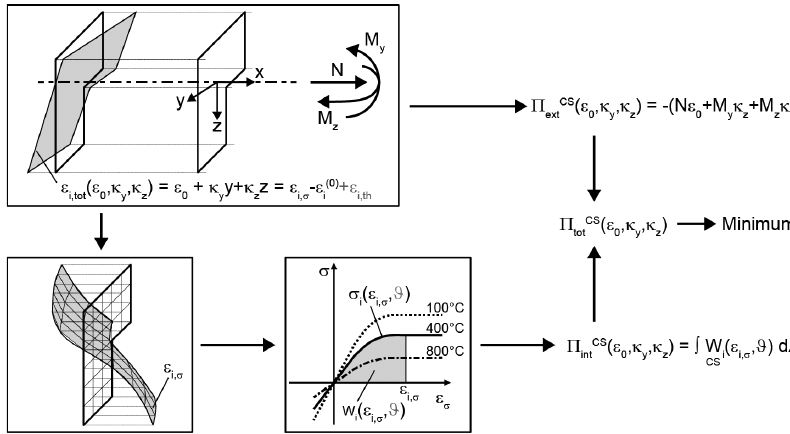
Fig. 4. Calculation scheme for the mechanical analysis based on the minimum of the total potential